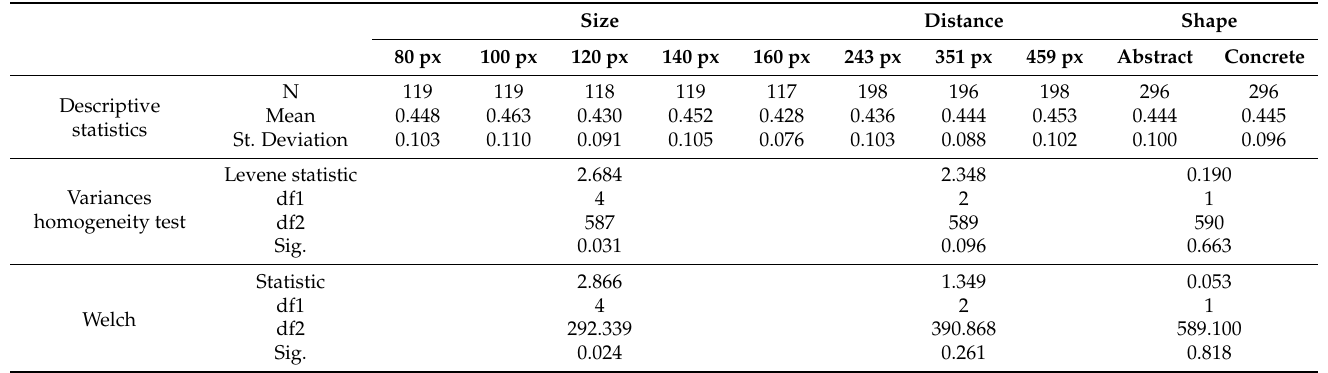
Table 3. One-way Welch’s ANOVA results for movement times of size, distance, and shape factors. Size Distance